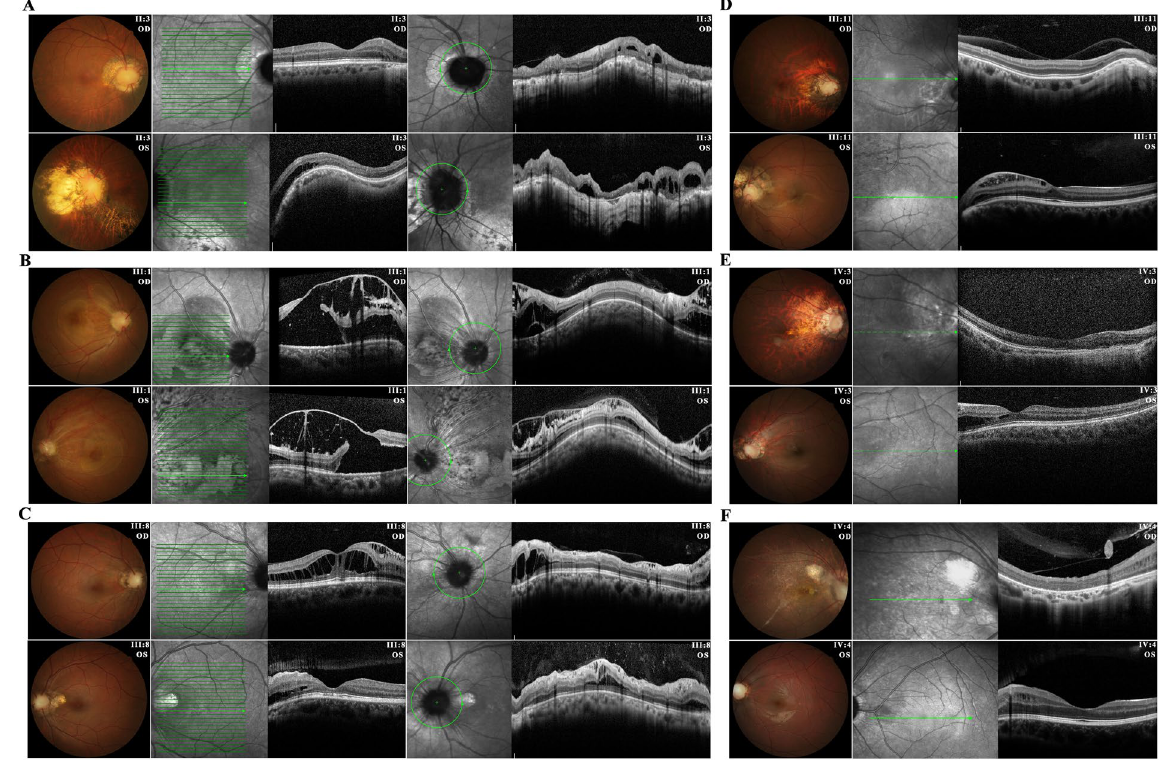
Figure 3. Fundus photos and SD-OCT images show retinoschisis and retinal/choroidal atrophy in six patients from family CL. ( A ) Fundus of patient II:3 presented retinal artery distortion, irregular RPE depigmentation and choroidal atrophy in both eyes. SD-OCT showed peripapillary retinoschisis in right eye, and retinoschisis extended to maculae and inferior temporal quadrant in left eye. ( B ) Fundus photo showed retinoschisis in both eyes of patient III:1 extended beyond the posterior pole. SD-OCT revealed bilateral peripapillary retinoschisis and cystic degeneration in the macular region with vitreomacular traction. ( C ) SD-OCT of patient III:8 revealed bilateral peripapillary retinoschisis and typical retinoschisis between inner nuclear layer (INL) and outer nuclear layer (ONL) with fovea involved in right eye, and close to fovea in left eye. ( D ) Funduscopy of patient III:11, who presented nystagmus, showed peripapillary retinoschisis, retinal artery distortion, and leopard-like choroidal atrophy in both eyes, and retinoschisis extended beyond posterior pole in left eye. SD-OCT showed epi-macular membrane in right eye, and typical retinoschisis within ganglial cells involving fovea in left eye. (E) The fundus of patient IV:3 demonstrated coloboma surrounding abnormal ONH and diffused leopard-like choroidal atrophy in both eyes. SD-OCT showed maculoschisis between INL and ONL in left eye and bilateral retinal atrophy. ( F ) Fundus photos and SD-OCT images of patient IV:4 revealed severe retinal degeneration with epi-macular membrane and vitreomacular traction in right eye, and typical retinoschisis within INL in left eye. Green arrowed lines denote scanned axis by SD-OCT. OD, right eye; OS, left